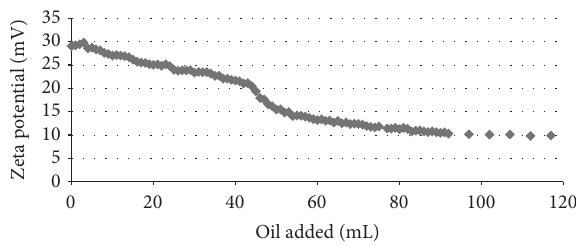
Figure 2: Zeta potential measurements for aqueous limestone sus- pension with volume of crude oil